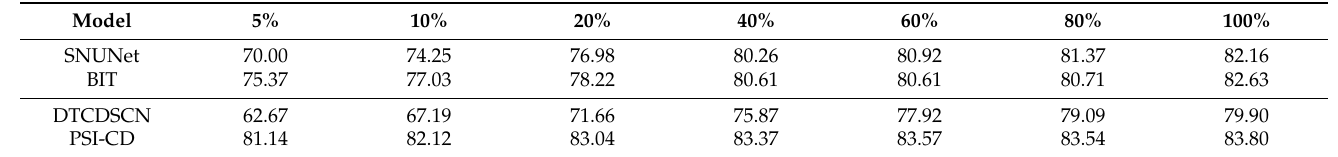
Table 4. Comparison of change detection results of different methods on LEVIR dataset with different data volumes (unit: